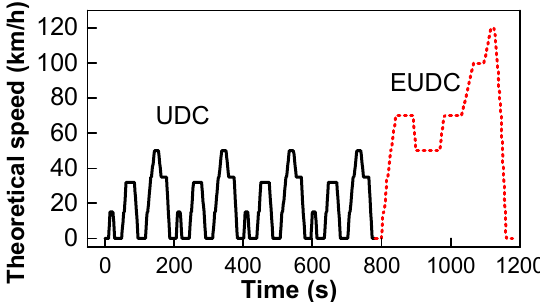
Figure 2. Vehicle speed of the New European Drive Cycle (NEDC) cycle. UDC: Urban Drive Cycle. 210